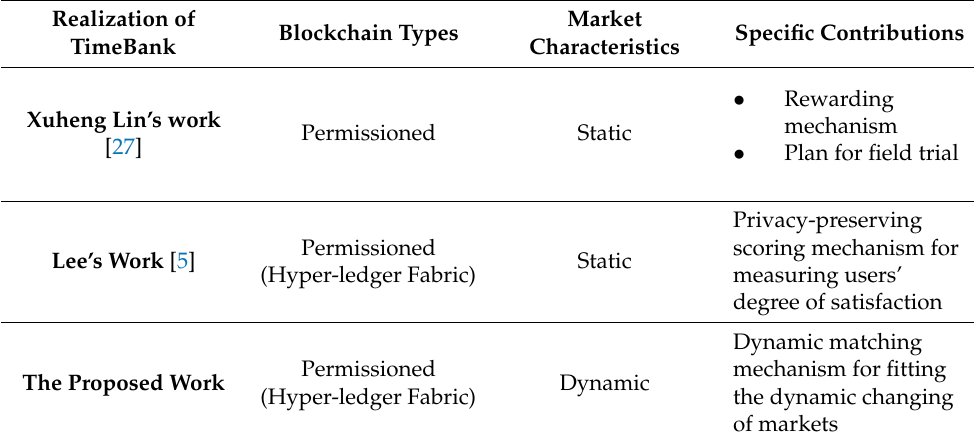
Table 3. The similarities and differences of the three mentioned TimeBank